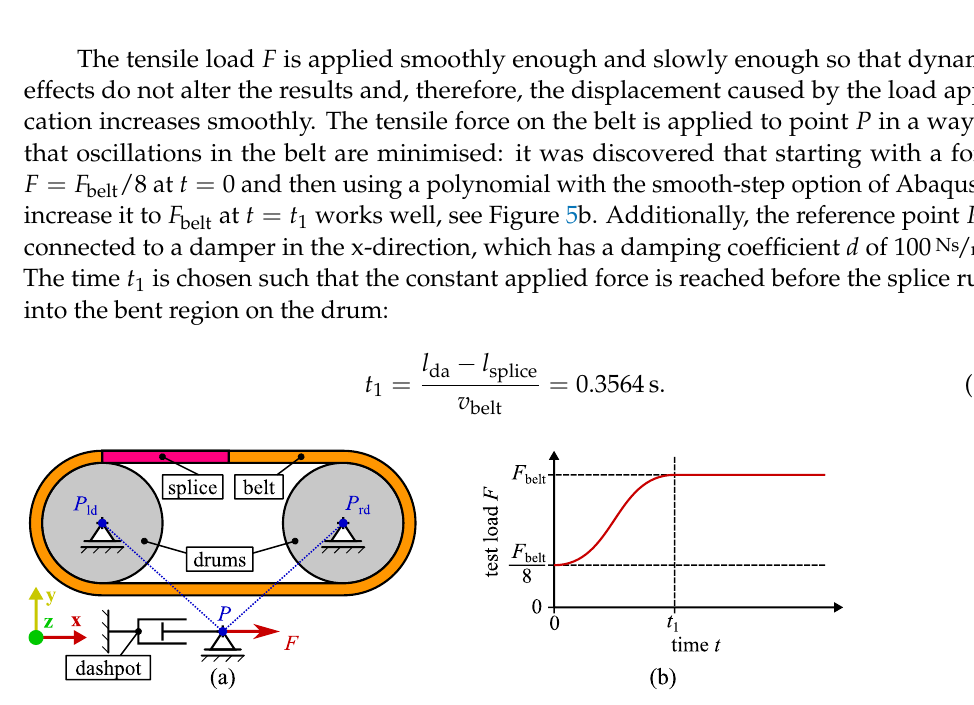
Figure 5. Setup of the conveyor belt test rig model ( a ) and applied test load vs. time curve ( b